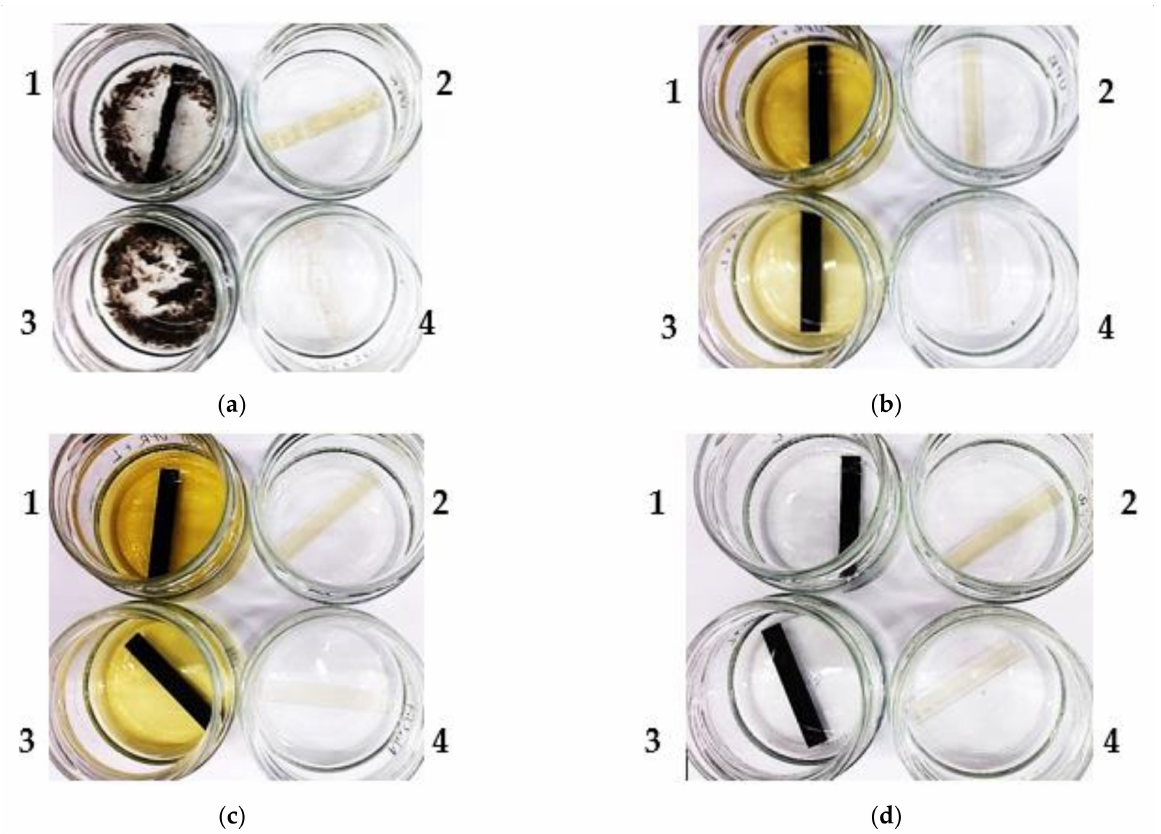
Figure 3. Images of the UPR and VER lignin-based composites during the immersion test in: ( a ) ace- tone; ( b ) sodium carbonate; ( c ) sodium hydroxide; ( d ) hydrochloric acid. 1—UPR + L; 2—UPR; 3—VER + L; 4—VER.